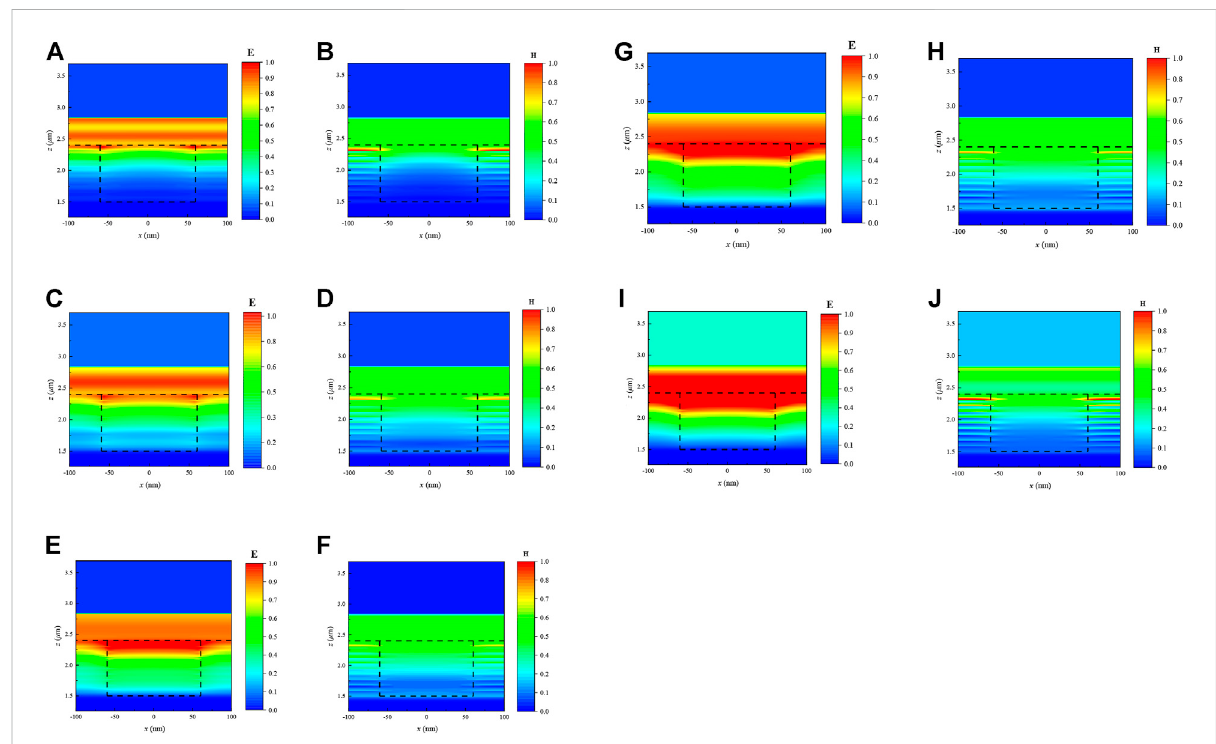
FIGURE 5 Compositestructureof LP =10, r =60 nm, a =200 nm, d M =10 nm, d D =80 nm, h =900 nm,andnormalizedelectromagnetic fi elddistribution clouds at